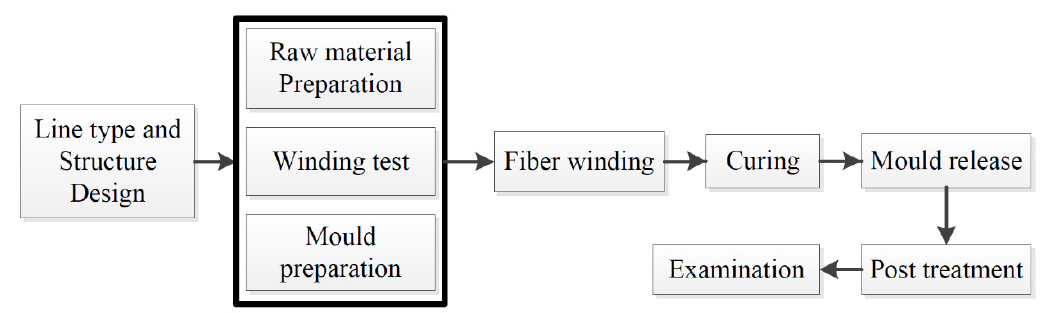
Figure 1. NOL ring fabrication preparation.